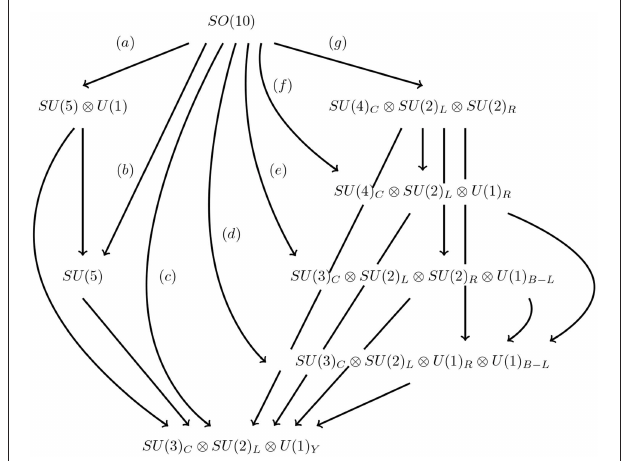
FIGURE 3 | Patterns of symmetry breaking from SO (10) to the SM group